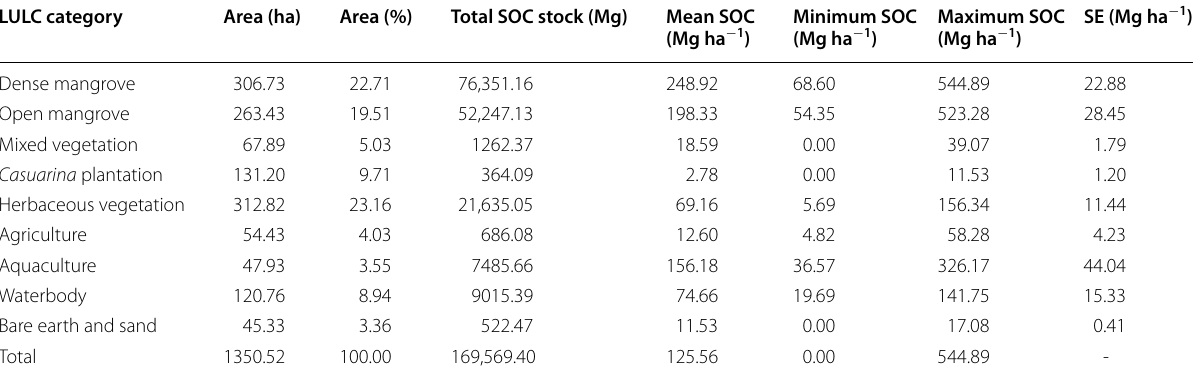
Table 5 Estimated total SOC stocks and mean, minimum, maximum and standard error (SE) values of SOC densities under